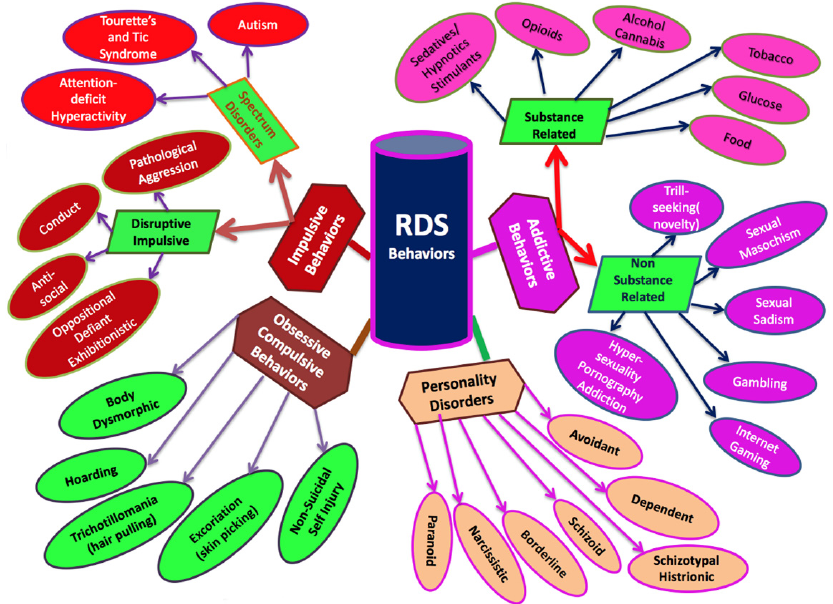
Figure 2. A schematic of RDS. This figure illustrates the categorization of RDS behaviors, showing which behaviors are addictive, impulsive, obsessive, and personality disorders. Sub-categories divide addictive behaviors into substance and non-substance related and impulsive into disrup- tive/impulsive and spectrum disorders. These behaviors have dopaminergic dysfunction in common: acute excess or chronic deficit of dopamine release in the brain reward